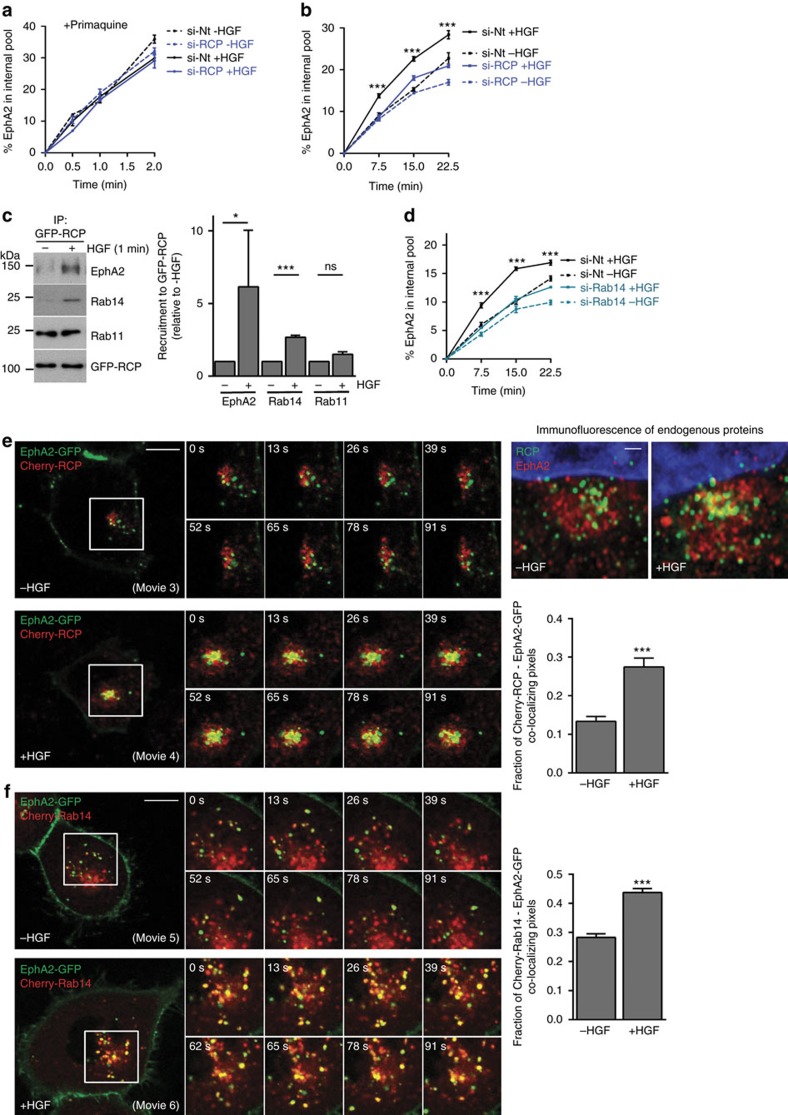
HGF-driven trafficking of EphA2 is controlled by RCP and Rab14.(a,b) H1299 cells were transfected with siRNAs targeting RCP (si-RCP) or a non-targeting control (si-Nt) and plated onto 10 cm plastic dishes. Cells were surface-labelled with NHS-S-S-Biotin (0.13 mg ml−1) at 4 °C and internalization allowed to proceed at 37 °C for the indicated times in the presence (a) or absence (b) of primaquine (0.6 mM), with or without HGF (10 ng ml−1). Biotin remaining at the cell surface was removed by exposure to MesNa at 4 °C and the quantity of biotinylated receptors within the cells determined by capture-ELISA using microtitre wells coated with monoclonal antibodies recognizing EphA2. Values are mean±s.e.m. from either one representative experiment performed in quadruplicate (a) or from three independent experiments (b), ***P<0.001 (si-RCP+HGF versus si-Nt+HGF); two-way ANOVA, Bonferroni post-test. (c) H1299 cells expressing GFP-RCP were incubated in the presence or absence of HGF (10 ng ml−1) for 1 min. Cells were lysed in a buffer containing 0.15% Tween-20 and GFP was immunoprecipitated as for Fig. 1c. The immunoprecipitates were analysed by immunoblotting using antibodies recognizing EphA2, Rab14, Rab11 and RCP. Recruitment of EphA2, Rab14 and Rab11 to GFP-RCP immunoprecipitates was quantified by densitometric scanning of western blots. Values are mean±s.e.m. from three independent experiments; *P<0.05, ***P<0.001, ns, not significant; Mann-Whitney test. Uncropped blots corresponding to the experiment presented in Fig. 3c are displayed in Supplementary Fig. 9. (d) H1299 cells were transfected with siRNAs targeting Rab14 (si-Rab14) or a non-targeting control (si-Nt) and internalization of EphA2 in the presence and absence of HGF was determined as for b. Values are mean±s.e.m. from three independent experiments, ***P<0.001 (si-Rab14+HGF versus si-Nt+HGF); two-way ANOVA, Bonferroni post-test. (e,f) H1299 cells were transfected with EphA2-GFP in combination with either mCherry-RCP (e) or mCherry-Rab14 (f) and plated onto glass-bottomed dishes, or were left untransfected. Twenty-four hours following transfection, confocal time-lapse movies were collected with 2 s frame intervals over a 2 min period in the presence and absence of HGF (10 ng ml−1). HGF was added 30 min before collecting the movies. Stills were extracted from movies 3-4 at the indicated time points following collection of the first frame of the movie and display the region of interest indicated by the white boxes. Bar, 10 μm. Olympus software was used to quantify co-localized pixels relative to the EphA2-GFP and mCherry-RCP pixels across the course of the movies, and these are plotted as the fraction of co-localizing pixels as determined by the Costes method39. Values are mean±s.e.m. from three separate experiments incorporating >60 cells per condition, ***P<0.001 Mann-Whitney test. In the right panels in e untransfected H1299 cells were incubated in the presence or absence of HGF (10 ng ml−1) for 30 min and then fixed. Endogenous RCP and EphA2 were visualized by immunofluorescence with respect to the cell nucleus (stained with DAPI) following by high resolution imaging using a high resolution Airy-scan microscope. Detail of the perinuclear region is displayed. Bar, 1 μm. The whole cell fluorescence micrographs and single channel fluorescence images of these Airy-scan images are presented in Supplementary Fig. 4a.